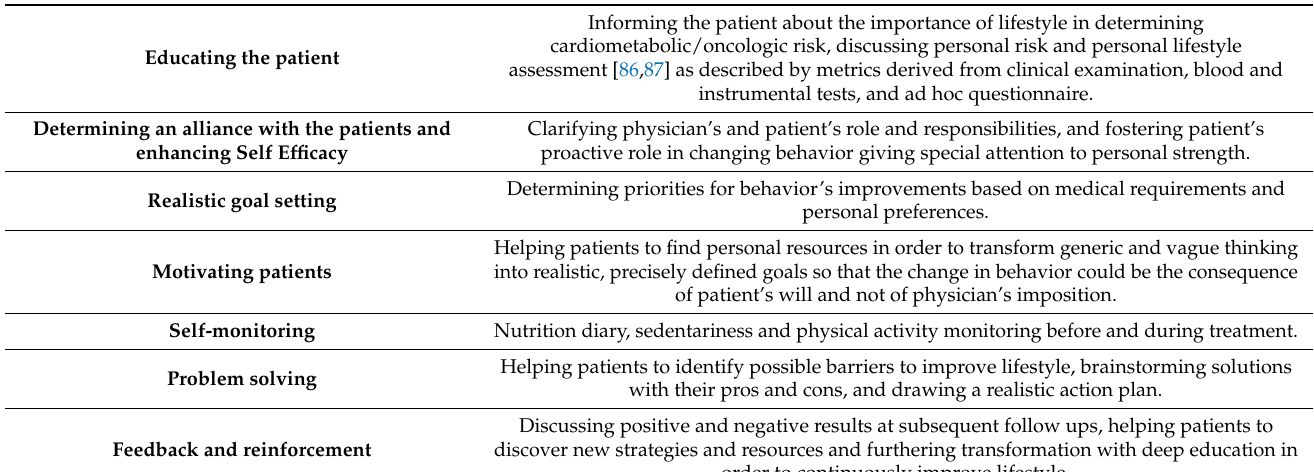
Table 2. Cognitive behavioral strategies (Cbs) applied in medical settings [17,84,85].